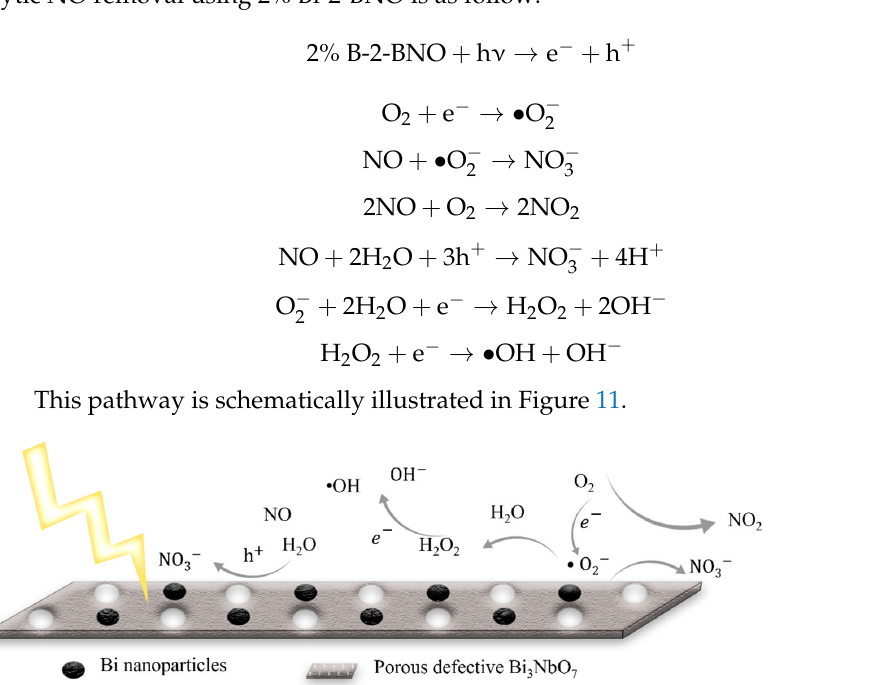
test, Figure S2: SEM images of 4%Bi ‐ 2 ‐ BNO, Figure S3: Elemental mapping of (a) 2%Bi ‐ 2 ‐ BNO cor ‐ responding to (b) Bi, (c) Nb and (d) O.